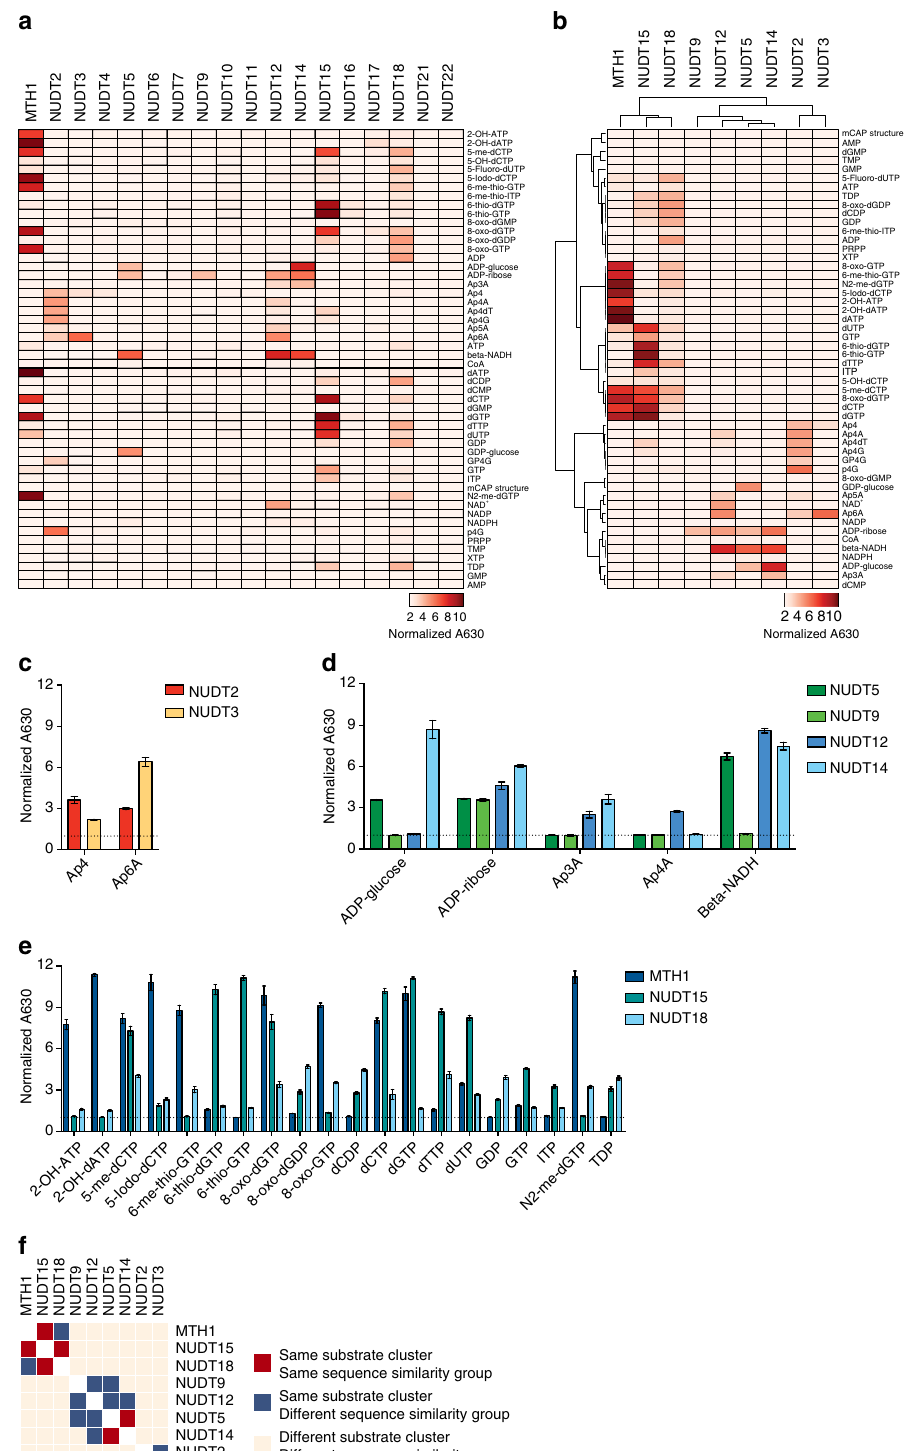
Fig. 2 Substrate activity of the human NUDIX hydrolases. a Activity of 18 human NUDIX hydrolases toward 52 substrates. Activity is represented in a heat map in which the absorbance at 630 nm normalized to untreated controls (this is, without BIP or PPase) is shown. The data represented correspond to the high enzyme concentration condition (200 nM); for the complete data set, see Supplementary Fig. 2d. b Hierarchical clustering heat map of the NUDIX hydrolases that displayed activity toward the corresponding substrates. Three distinct clusters appear containing MTH1, NUDT15, and NUDT18; NUDT5, NUDT9, NUDT12, and NUDT14; and NUDT2 and NUDT3. c NUDT2 and NUDT3 activity toward their corresponding substrates. d NUDT5, NUDT9, NUDT12, and NUDT14 activity toward their corresponding substrates. e MTH1, NUDT15, and NUDT18 activity toward their corresponding substrates. f Cluster co-assignment matrix comparing sequence similarity grouping and substrate activity